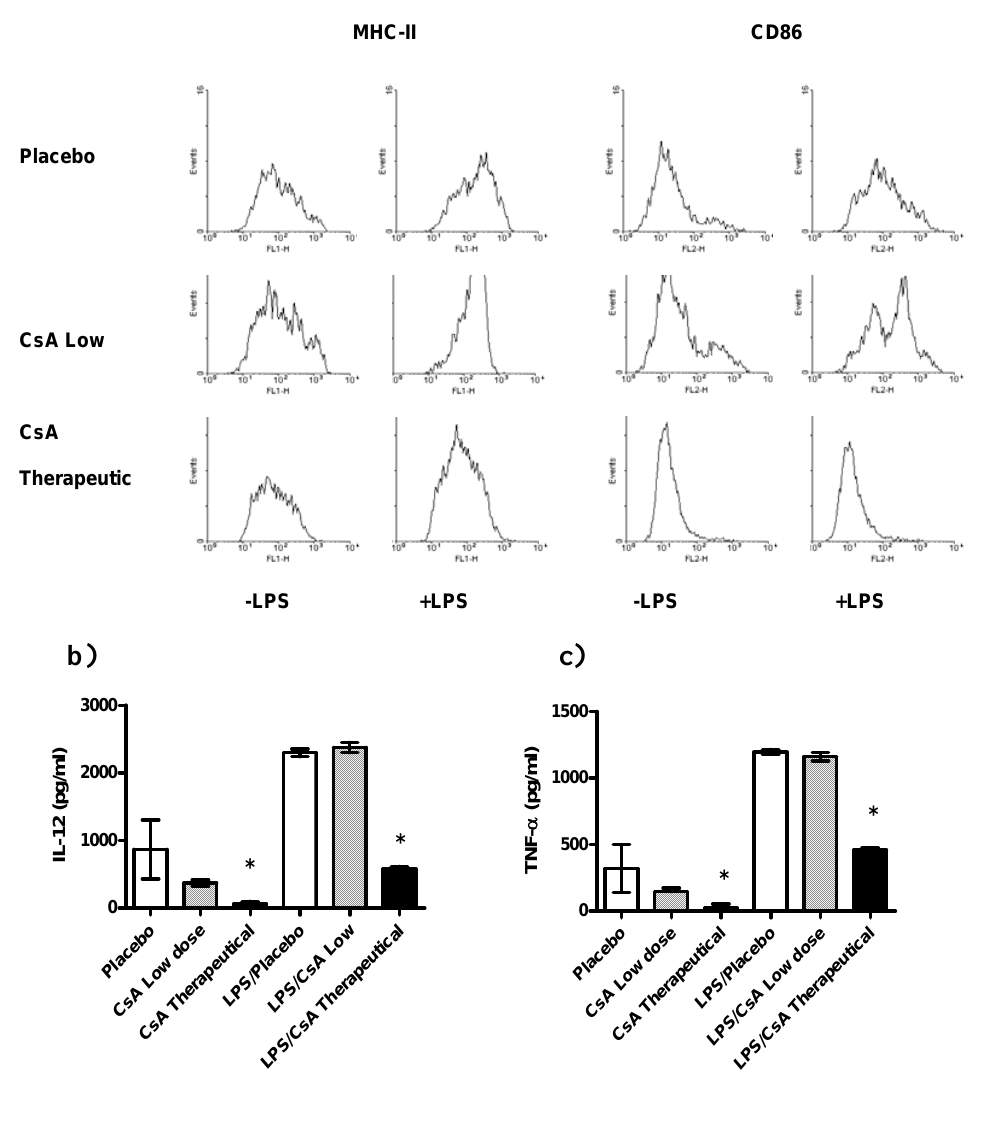
Figure 6. Differential effect of CsA doses on dendritic cells (DC) maturation and activation. DCs were developed from bone marrow of healthy mice, and culture with GM-CSF for 5 days, then DCs were stimulated or not with LPS 1 μ g/mL in presence of therapeutic or low dose of CsA or placebo. a ) Low dose of CsA do not alter DC maturation, but therapeutic dose of CsA significantly inhibits DC expression of MHC-II and CD86. b - c ) Twenty four hours later supernatants were collected and analyzed for IL-12 and TNF- α production by ELISA. * p < 0.05 compared with placebo. Data represent 2 independent experiments.